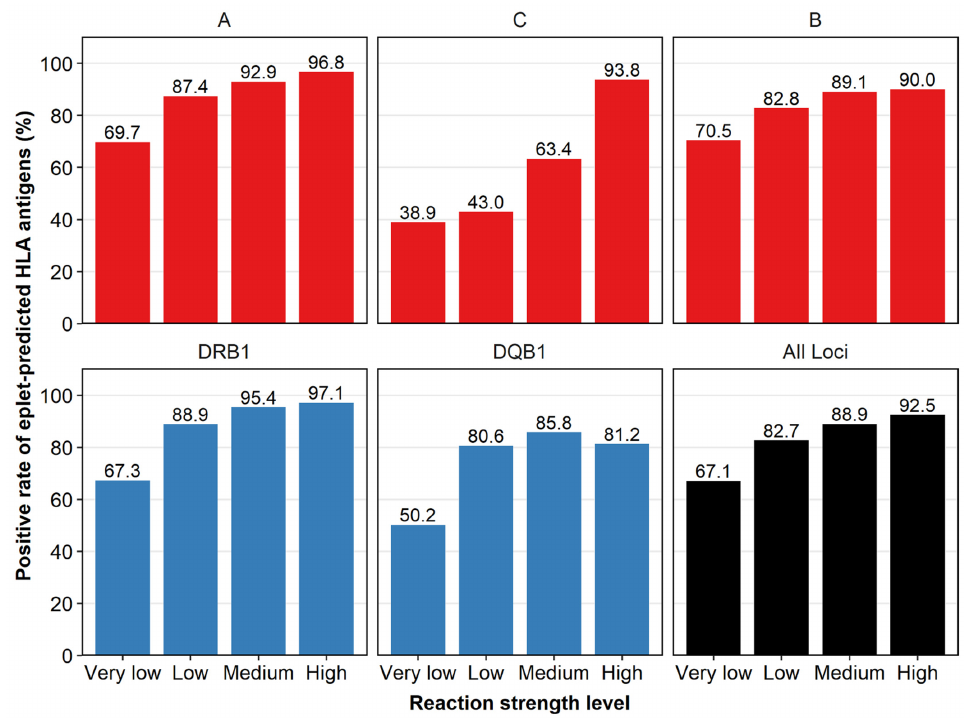
Figure 3. Concordance between LSA antigens and eplet-predicted (EP) HLA antigens at very low (1000–2000), low (2000–4000), medium (4000–10,000), and high (>10,000) reaction strength levels. Positive rates were the percentage of the number of positive over the total number of EP HLA anti- gens (if they existed in the LSA kits) when the LSA antigens were positive. The higher the reaction strength, the larger the positive rate of EP antigens. The concordance was found at different HLA loci. Class I, class II and all HLA antigens were colored red, blue, and black, respectively.